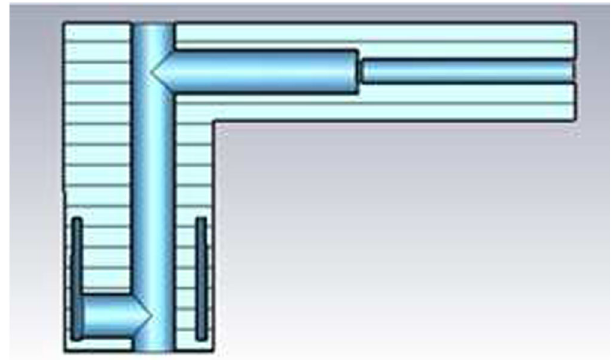
FIG. 26. Filter design for the vertical and horizontal HOM couplers.